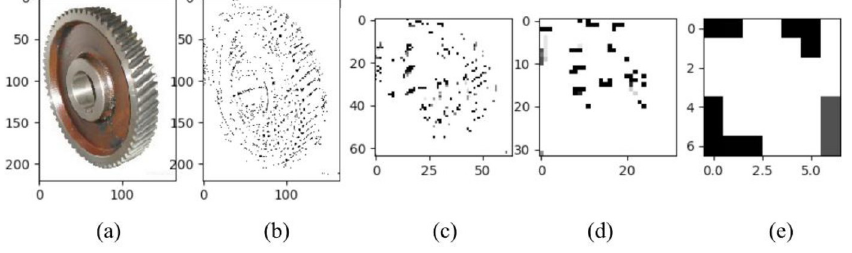
Fig 1. The original image of a gear and its feature map of sizes 220 × 165, 64 × 64, 32 × 32, and 7 × 7.